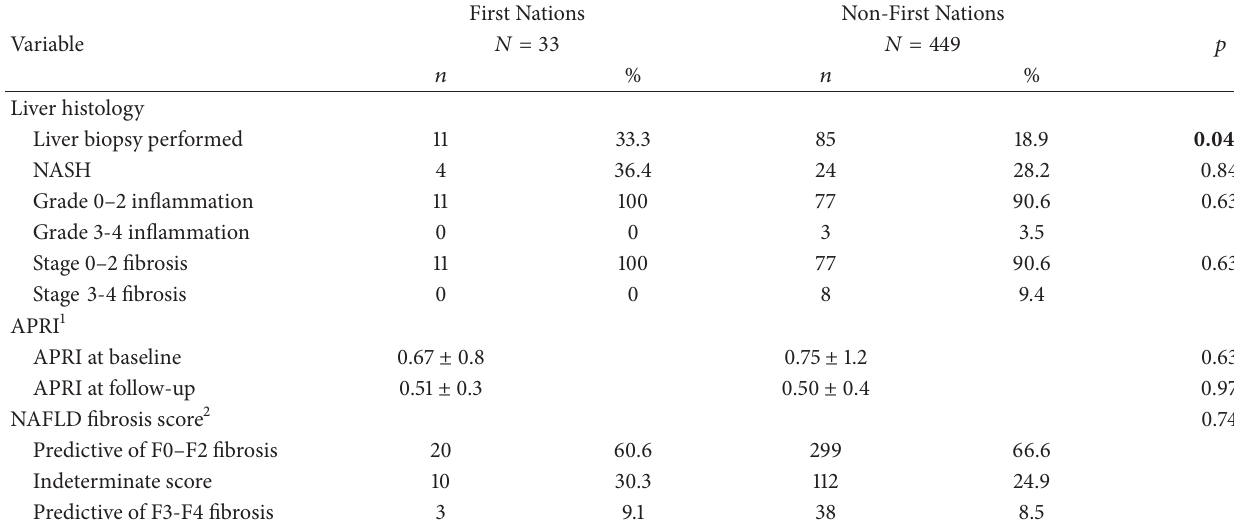
Table 3: Invasive and noninvasive tests for advanced liver disease in First Nations and Non-First Nations patients with nonalcoholic fatty liver disease.